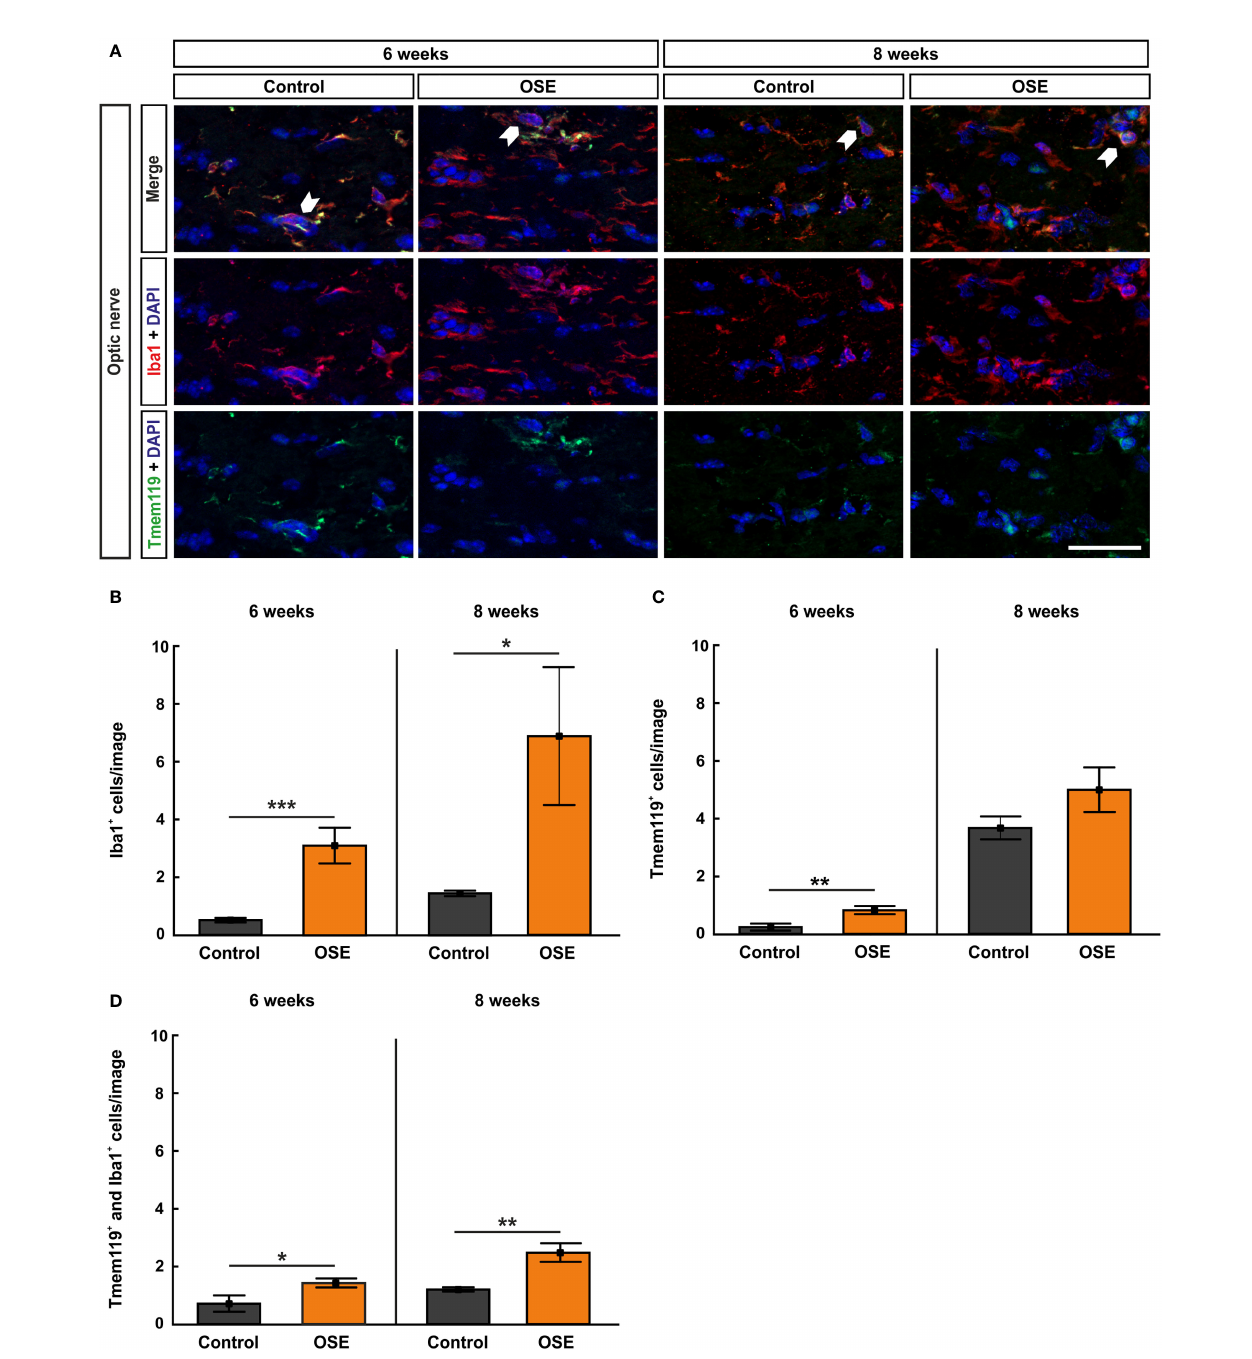
FIGURE 4 | Increased numbers of microglia/macrophages in the optic nerve. (A) Optic nerve sections were stained with Iba1 (red, microglia/macrophages) and Tmem119 (green, microglia) at six and after eight weeks. White arrows indicate co-localized Tmem119 + and Iba1 + cells. (B) The number Iba1 + cells was signi fi cantly increased in the OSE group after six weeks. The staining after eight weeks still displayed an increase of Iba1 + cells among the OSE group. (C) Tmem119 + cells were also increased after six weeks. No difference of the number of Tmem119 + cells was measurable between both groups at eight weeks. (D) A higher number of microglia (Tmem119 + and Iba1 + ) was observed at six weeks. This elevation was still noted in the OSE group at eight weeks. Data are shown as mean ± SEM. *p < 0.05, **p < 0.01, ***p < 0.001. Scale bar: 20 m